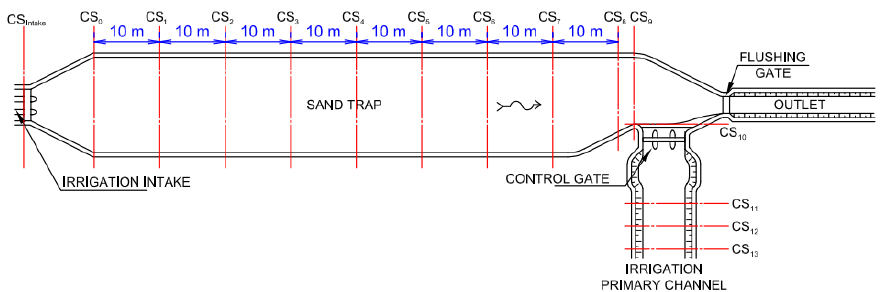
Figure 4. The layout for measuring cross-sections, which contains fourteen cross-sections starting from the irrigation intake until the beginning part of the irrigation primary channel.